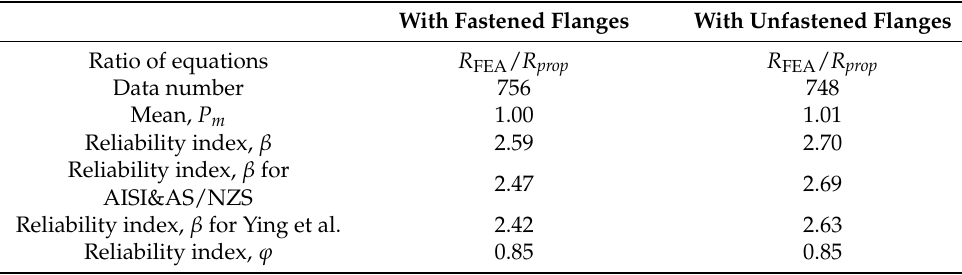
Table 9. Reliability analysis of the proposed equations (offset-hole